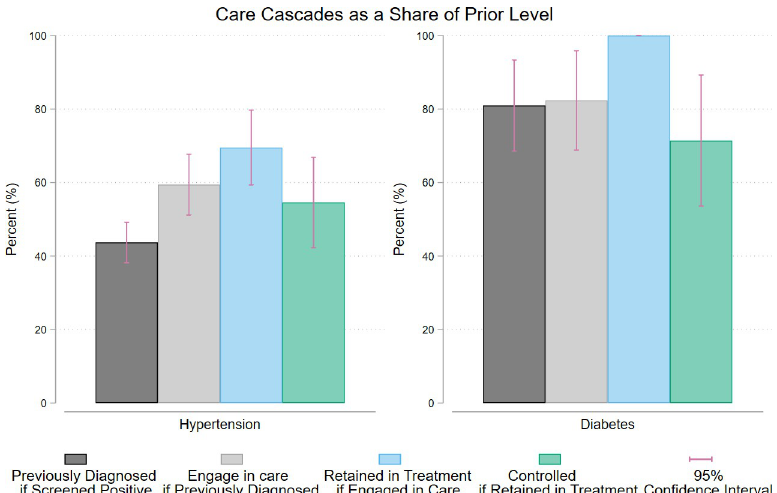
Fig 3. Steps in the care cascade by percent of prior level for hypertension and diabetes. This shows the share of people who were previously diagnosed with the condition if they screened positive, the percent who were engaged in care if previously diagnosed, the percent retained in treatment if they were engaged in care, and the percent that had their condition controlled if they were retained in